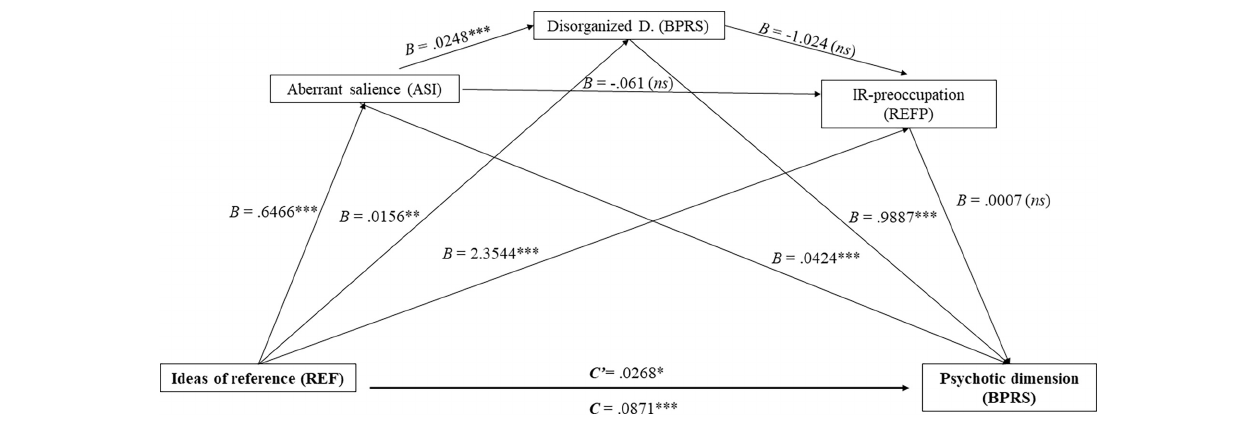
FIGURE 2 | Mediation model proposed and tested; c (cid:48) = direct effect of X; c = total effect of X on Y; on Y; ∗∗ p < 0.01; ∗∗∗ p < 0.001; ns = not statistically significant. Coefficients shown are unstandardized.